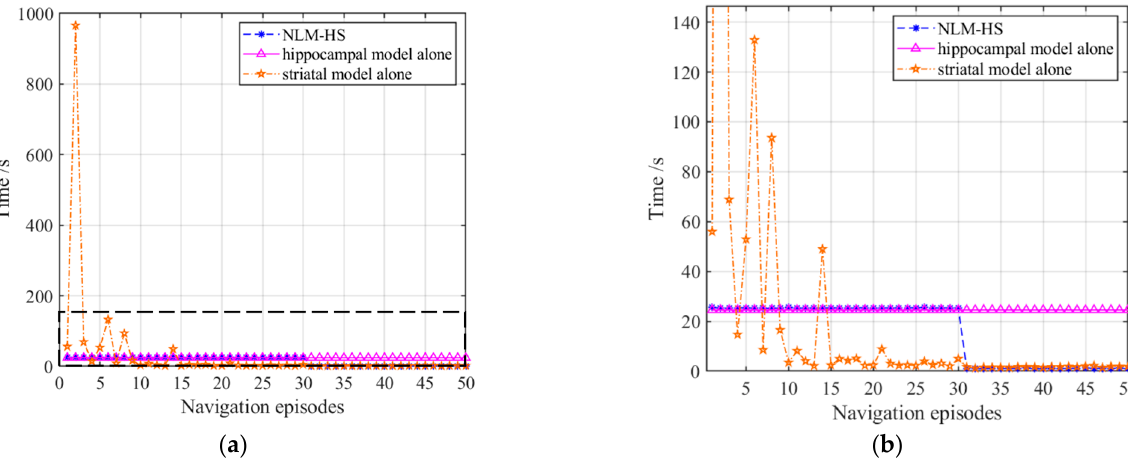
Figure 25. Comparison of navigation time of the three models. ( a ) Comparison of navigation time; ( b ) Enlarged version of the dotted box in ( a ).